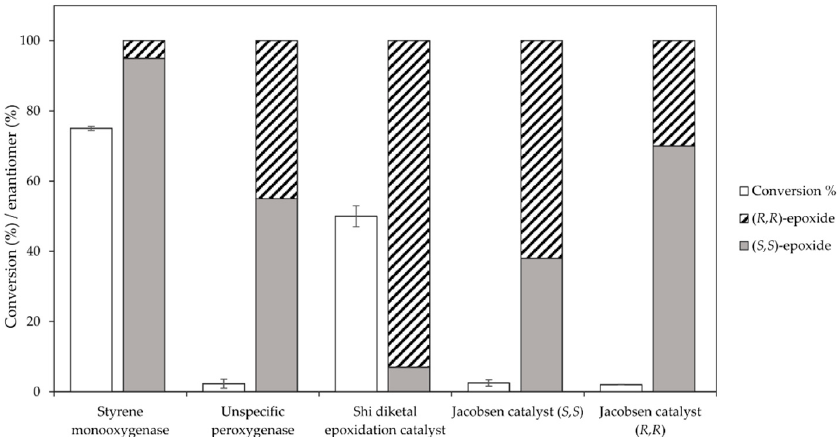
Figure 1. Catalyst screening for the epoxidation of 5 mM trans -2-heptene ( 4 ) at 1 mL scale using the styrene monooxygenase from Rhodococcus sp. ST-10, the unspecific peroxygenase from A. aegerita , the Shi epodixation diketal catalyst and both ( R,R )- and ( S,S )-enantiomers of the Jacobsen catalyst.